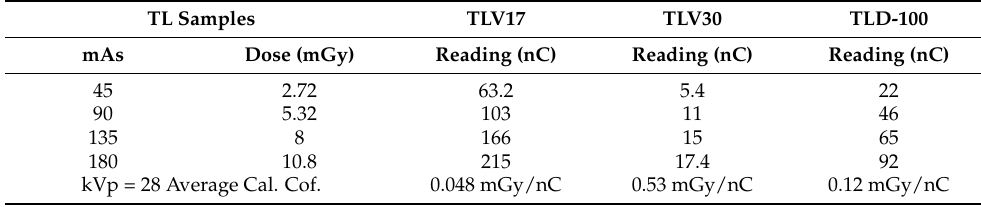
Table 4. TLV17, TLV30 and TLD-100 mammography radiation dose